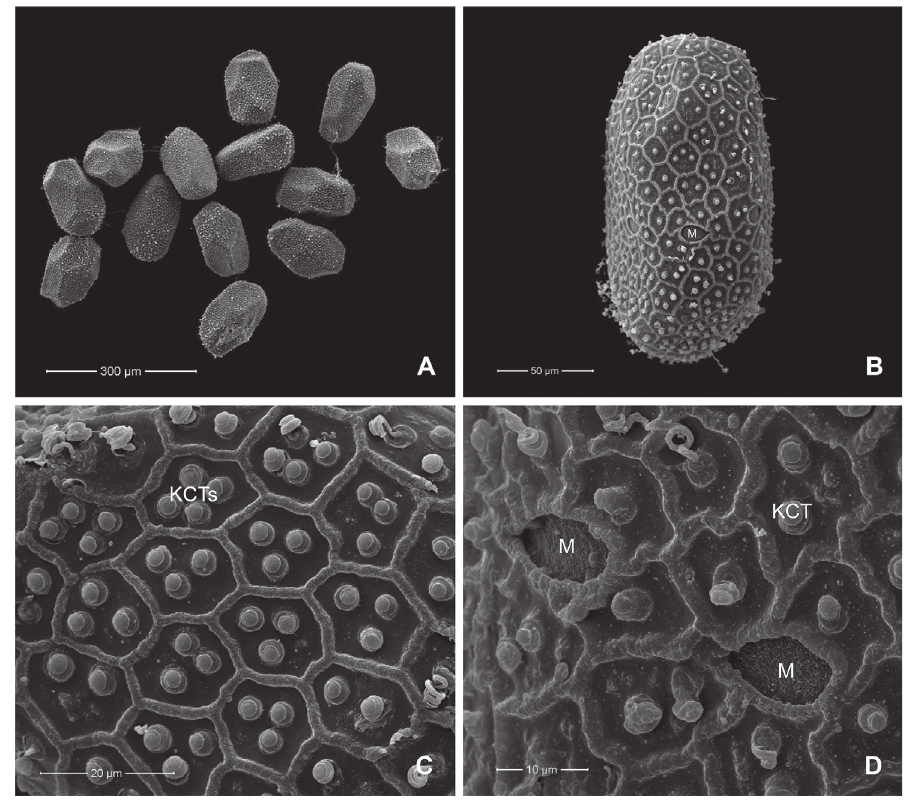
Figure 9. Paegniodes sapanensis sp. nov., scanning electron micrographs of egg (dissected from subimago) A eggs B general outline C chorionic surface D micropyle. M = micropyle, KCTs = knob-terminated coiled